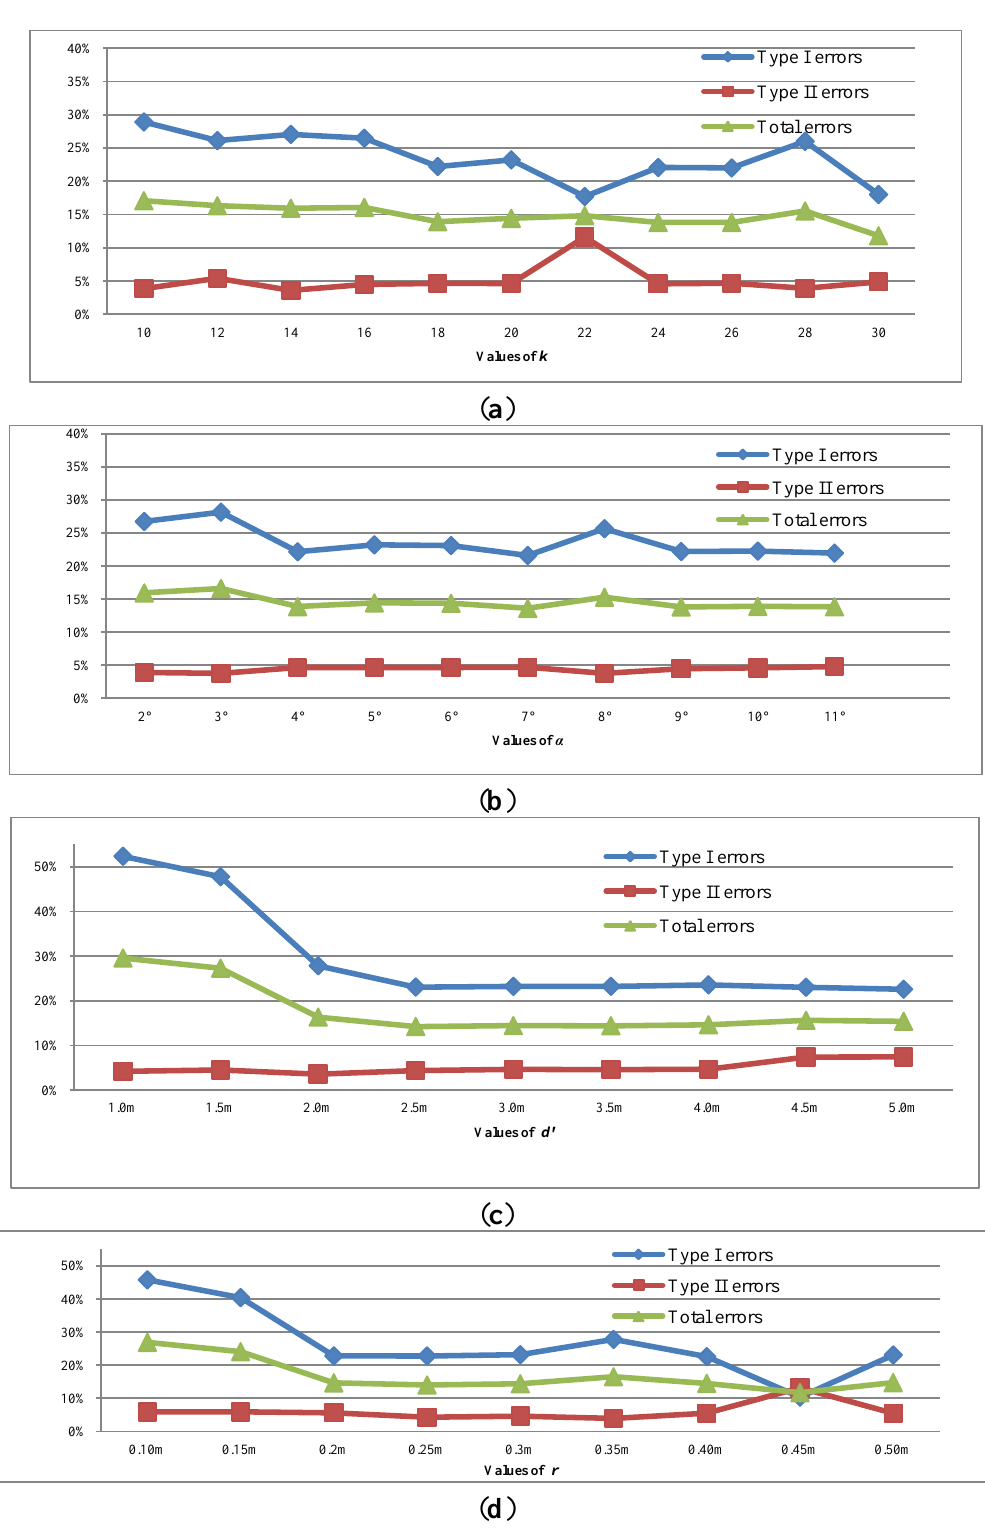
Figure 14. Analysis on sensitivity of the input parameters k and α respectively, and its effect on the three types of errors for the Sample 23. ( a ) Values of k and the corresponding three types of errors when r = 0.3 m, d' = 3.0 m and α = 5°; ( b ) Values of α and the corresponding three types of errors when k = 20, r = 0.3 m, d' = 3.0 m; ( c ) Values of d' and the corresponding three types of errors when k = 20, r = 0.3 m, α = 5°; ( d ) Values of r and the corresponding three types of errors when k = 20, d' = 3.0 m, α =